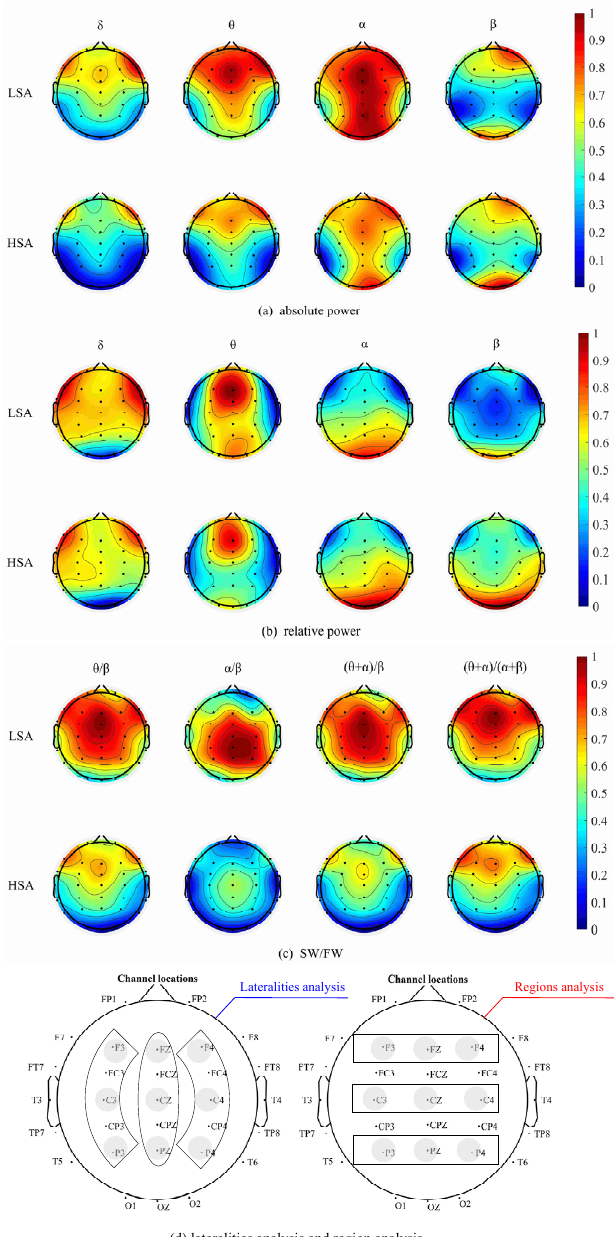
Figure 2. Three types of EEG features and channel locations for the two SA groups.